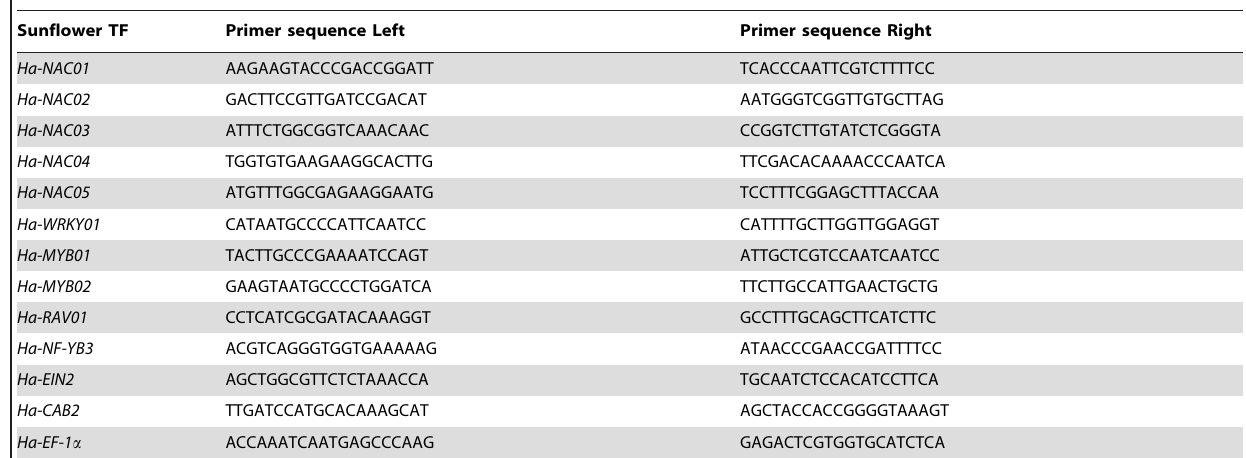
Table 1. Primer sequences for qPCR